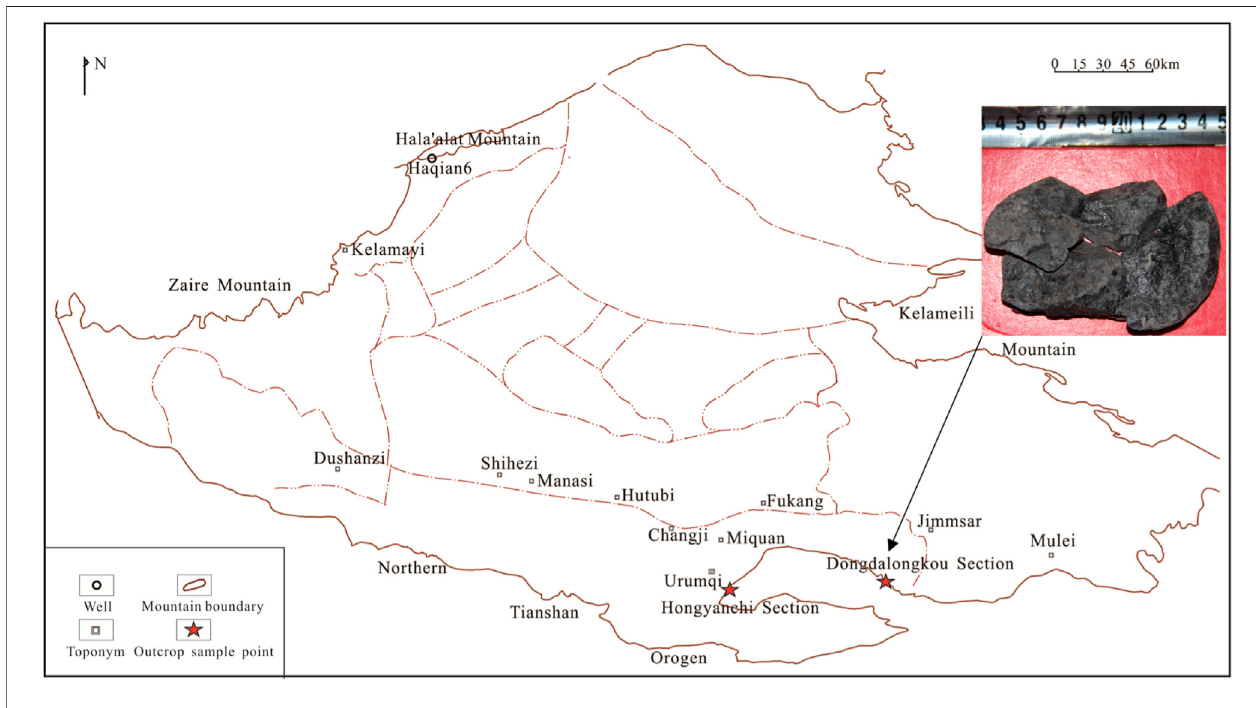
FIGURE 1 | Regional geological map of the Junggar Basin and the sample locations.